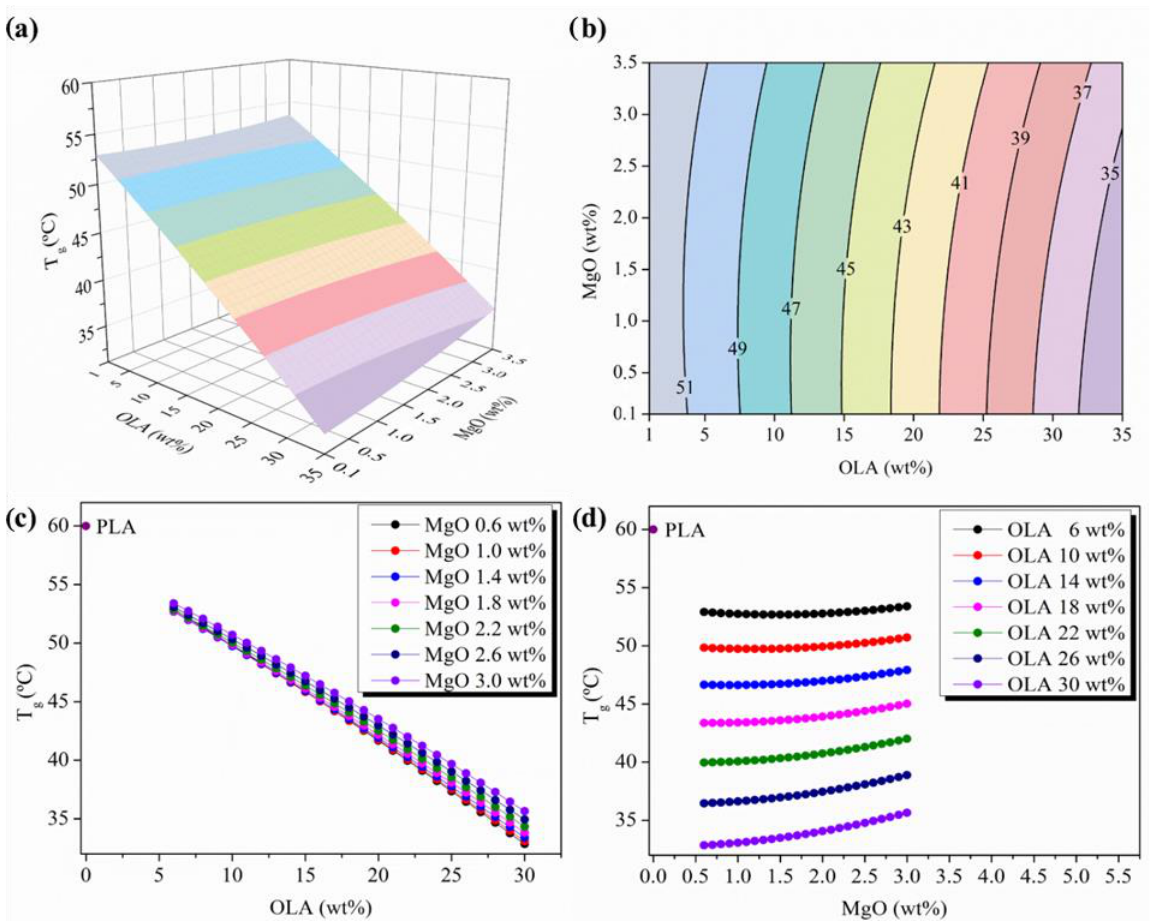
Figure 5. ( a ) 3D response surface plot and ( b ) contour plot of the glass transition temperature as a function of OLA and MgO NPs content, colours changes are attributed to an increment of 2 °C in the T g . ( c ) Parametric evolution of glass transition temperature with OLA content for different amounts of MgO NPs levels. ( d ) Parametric evolution of glass transition temperature with MgO NPs content for different amounts of OLA amounts.